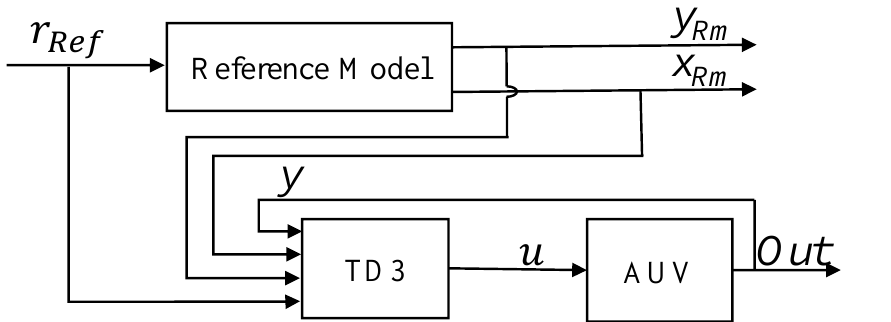
Figure 2. Schematic of the control system; this framework is built from control theory